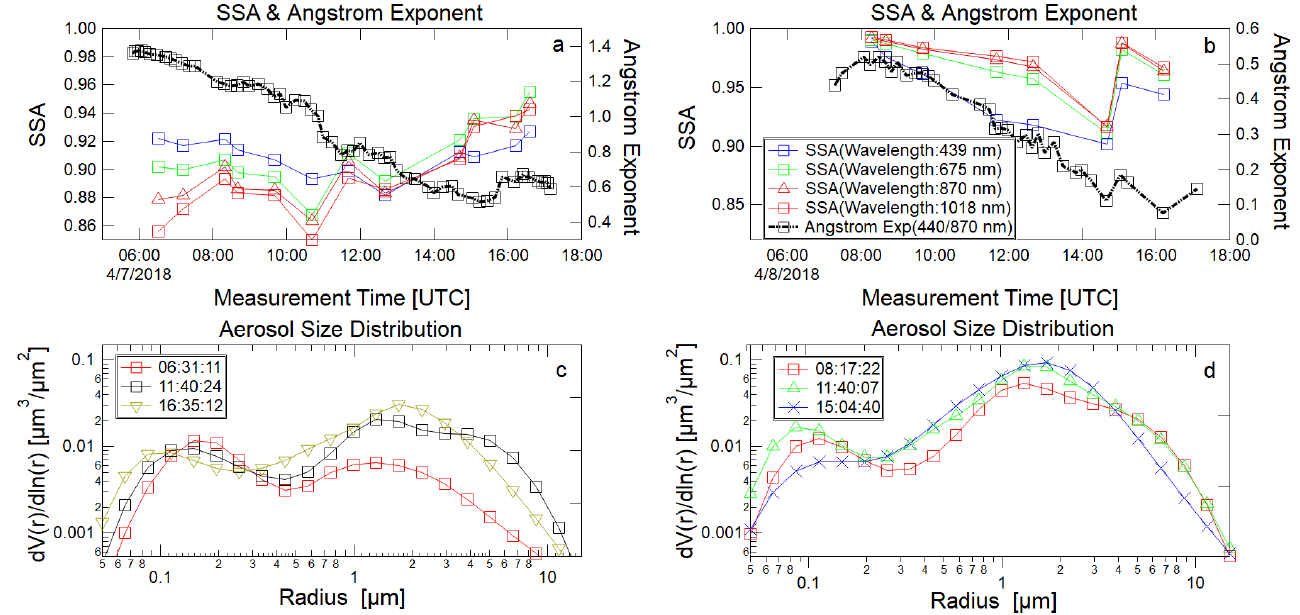
Figure 9. Single scattering albedo and Angstrom exponents ( a , b ) and aerosol size distribution ( c , d ) from sun photometer measurements for 7 April ( left ) and 8 April ( right ),